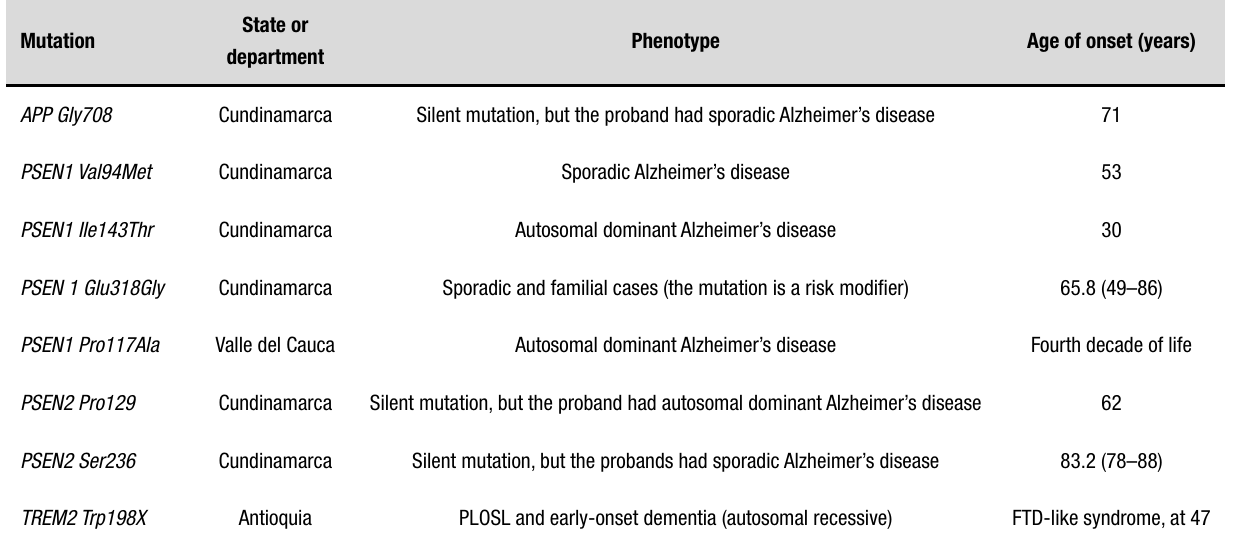
Table 1. Colombian mutations (besides Presenilin 1 E280A , Presenilin 1 I416T , and APOE3ch